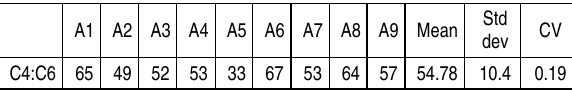
Table 41. Consortium C4:C6 performance